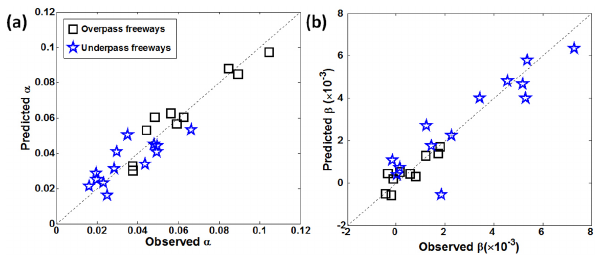
Figure 10. Comparisons of predicted dispersion coefficients (a) α ( R 2 = 0.88) and (b) β ( R 2 = 0.86) with the values extracted from observed concentration profiles. Black squares are for the overpass freeway transects (DTLA and Paramount) and blue stars for under- pass freeways (Carson and Claremont). Dotted line represents 1:1